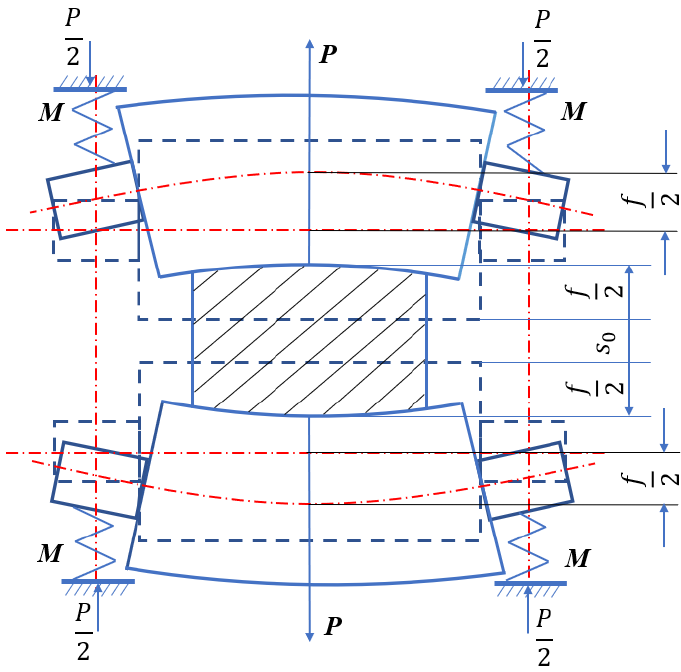
Figure 3. Schematic diagram of elastic deformation of rolling gap.